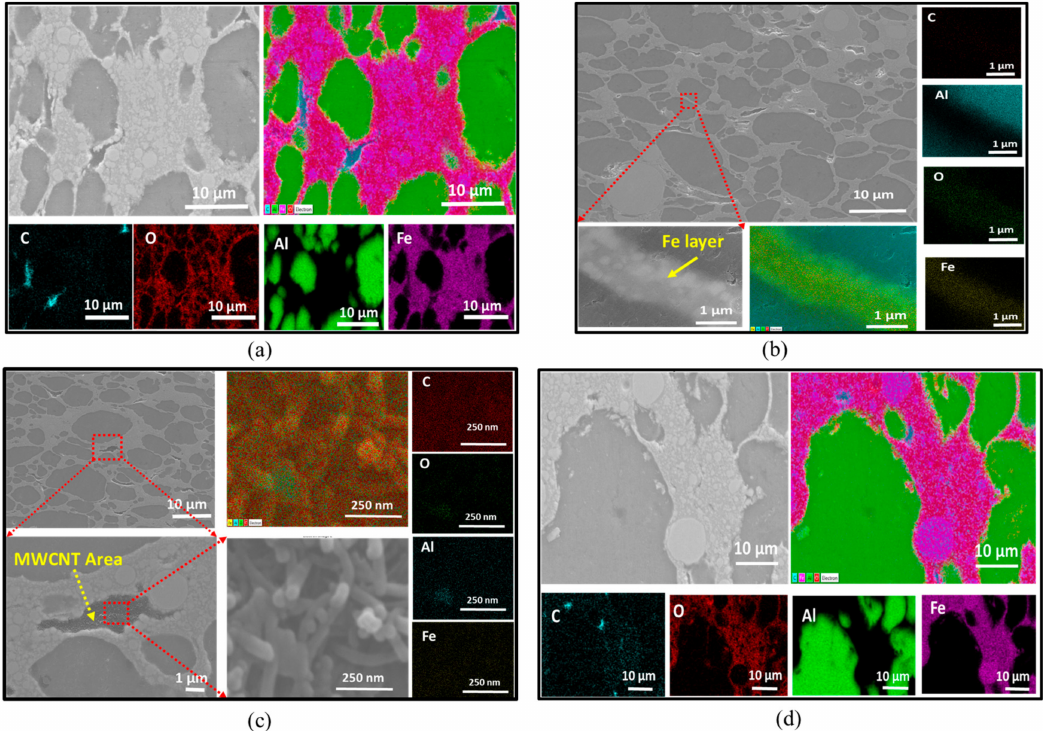
Figure 3. Energy Dispersive Spectroscopy (EDS) mapping: ( a ) 33Fe-65Al-2MWCNT (M1); ( b ) Higher magnification of selected region in 33Fe-65Al-2MWCNT (M1); ( c ) Higher magnification of selected region in 38Fe-60Al-2MWCNT (M2) with MWCNT area; and ( d ) 65Fe-33Al-2MWCNT